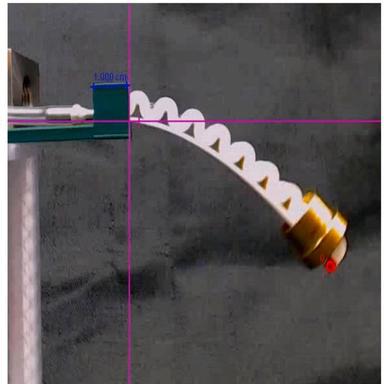
Experimental test setup for the loaded case.